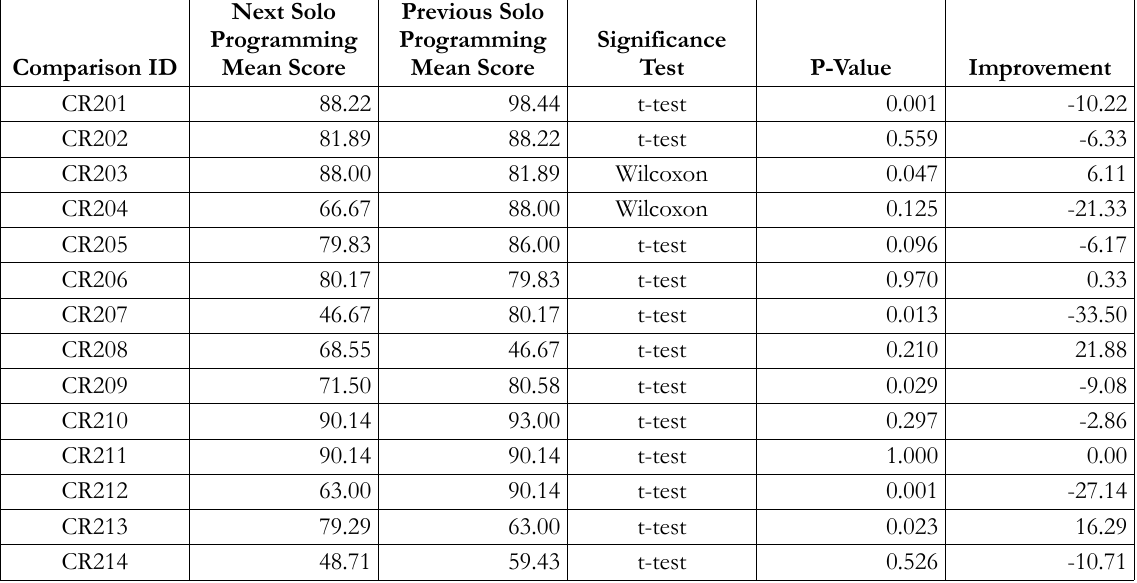
Table 7. The Individual Improvements Gained by Utilising Pair Programming for Slow-Paced